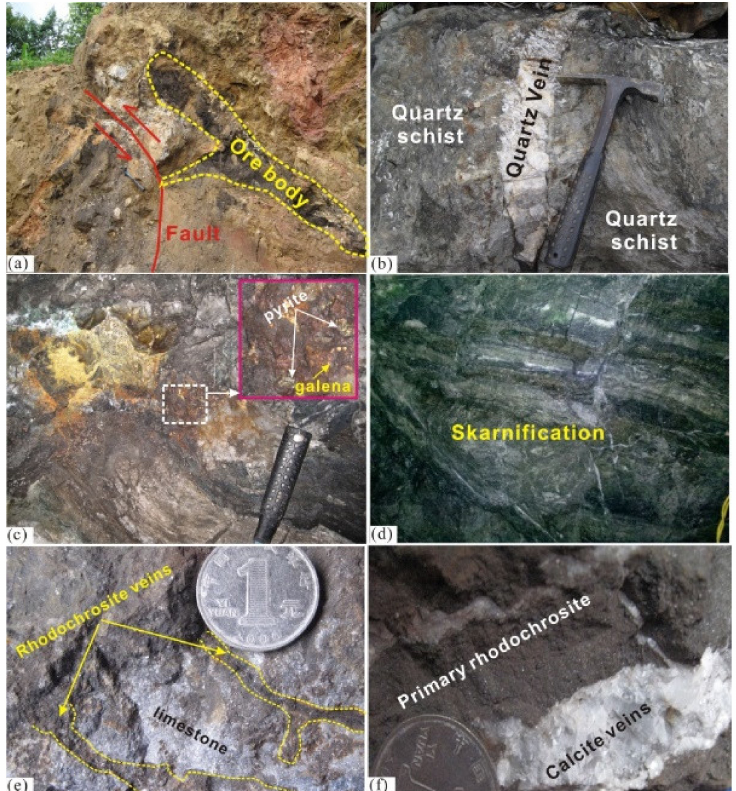
Figure 3. Photographs of the Mn–Ag orebodies in the Sanbao deposit: ( a ) contact relationship between Mn–Ag orebodies and the fault; ( b ) quartz vein cut through the quartz schist; ( c ) lead–zinc mineralization in wall rock; ( d ) skarn alteration; ( e ) some rhodochrosite was distributed by vein in limestone; ( f ) fracture developed in the primary rhodochrosite and fracture filled with